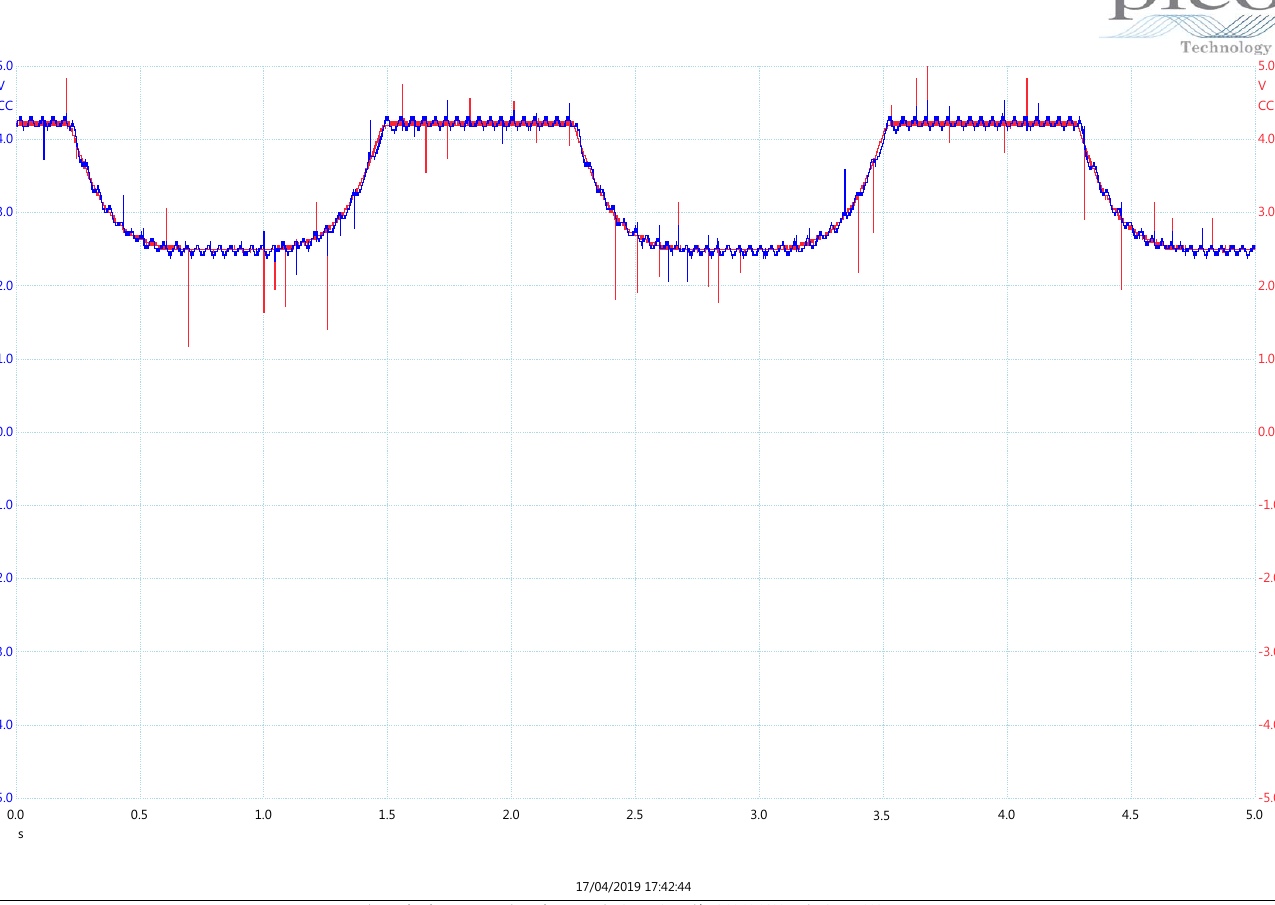
Figure 10. Experimental measurements. The blue line is the measured throttle angular position and the red line is the desired throttle motion. In this experiment, we set this reference instruction in order to capture the controller ability to track a cutted reference